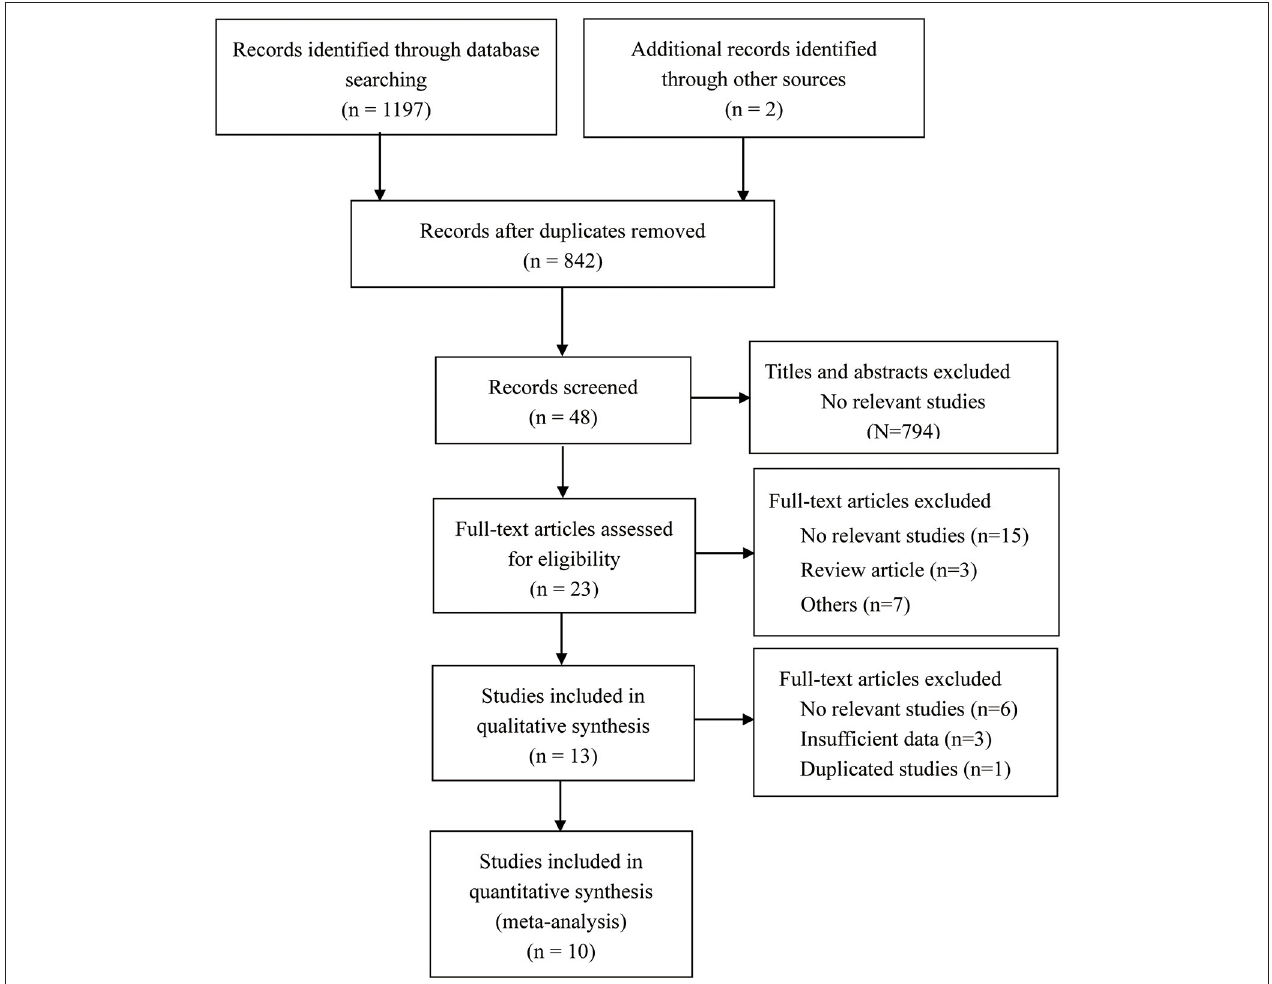
FIGURE 1 | Flow chart of the included studies in the meta-analysis.